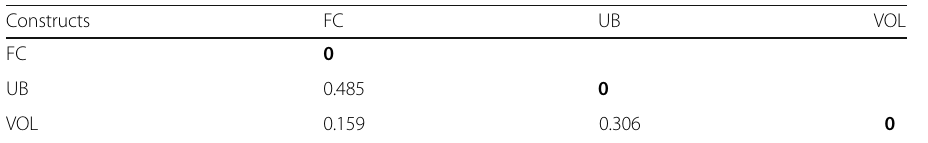
Table 3 Heterotrait-monotrait ratio (HTMT)